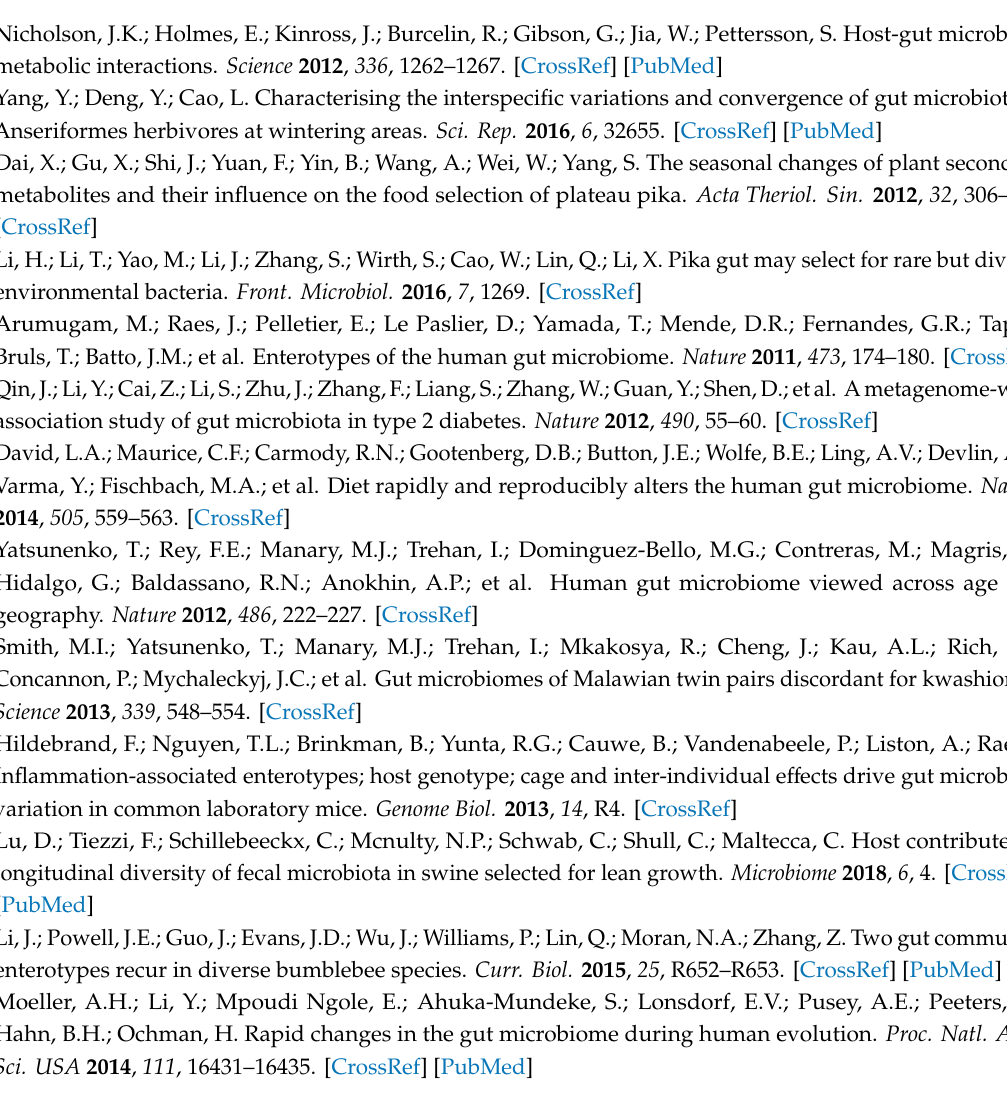
Figure S1: CH index based on the Bray–Curtis and Jaccard distance metrics, Table S1: Main components of the pika feed, Table S2: Distribution of enterotypes with respect to sampling time, Table S3: Network indices of the three enterotypes in plateau pikas, Table S4: Contribution of hierarchical functional categories (KEGG pathway levels 2 and 3) to total variance among the three